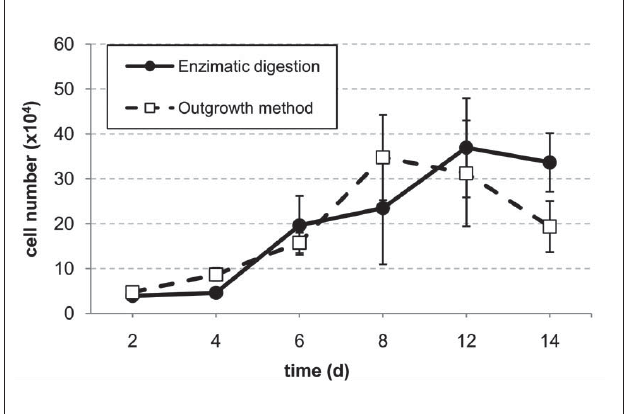
Fig. 2. Permanent dental pulp cells growth curves comparing different methods, outgrowth and enzymatic digestion using colagenase type I plus dispase, cultured with D-MEM supplemented with 20%